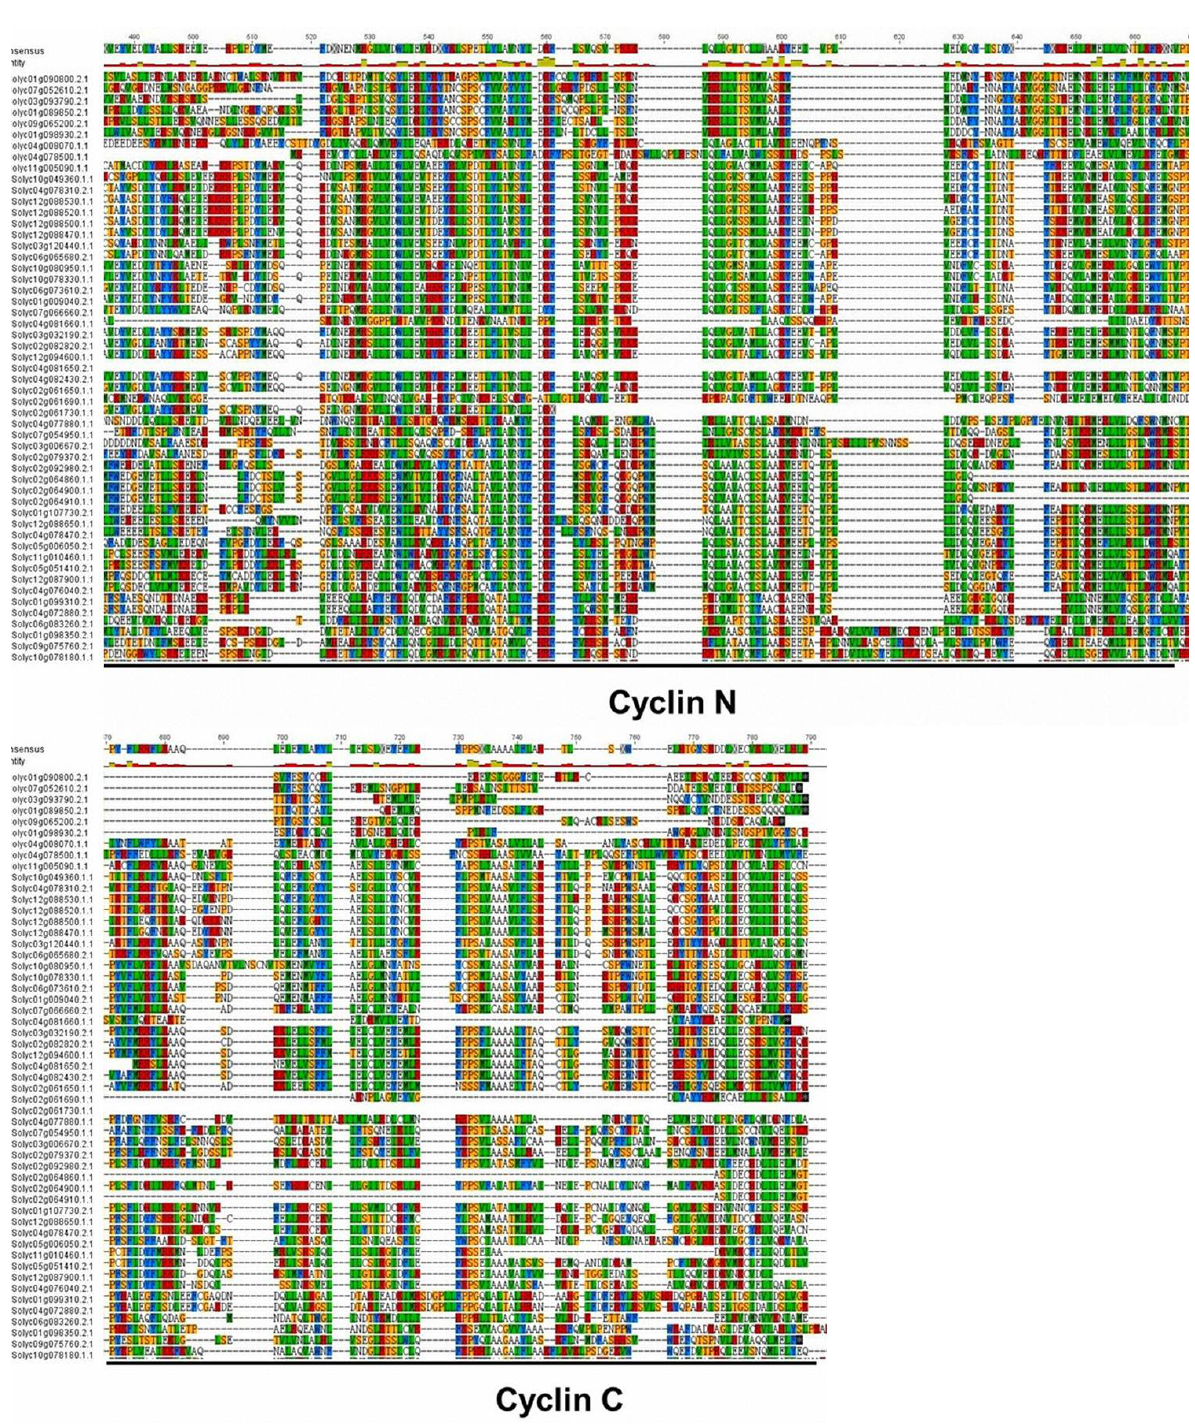
Figure 2. Alignment of cyclin domains. Gene identity numbers are provided on the left. Color shading indicates types of amino acid residues conserved. The defined regions cyclin-N and cyclin-C are